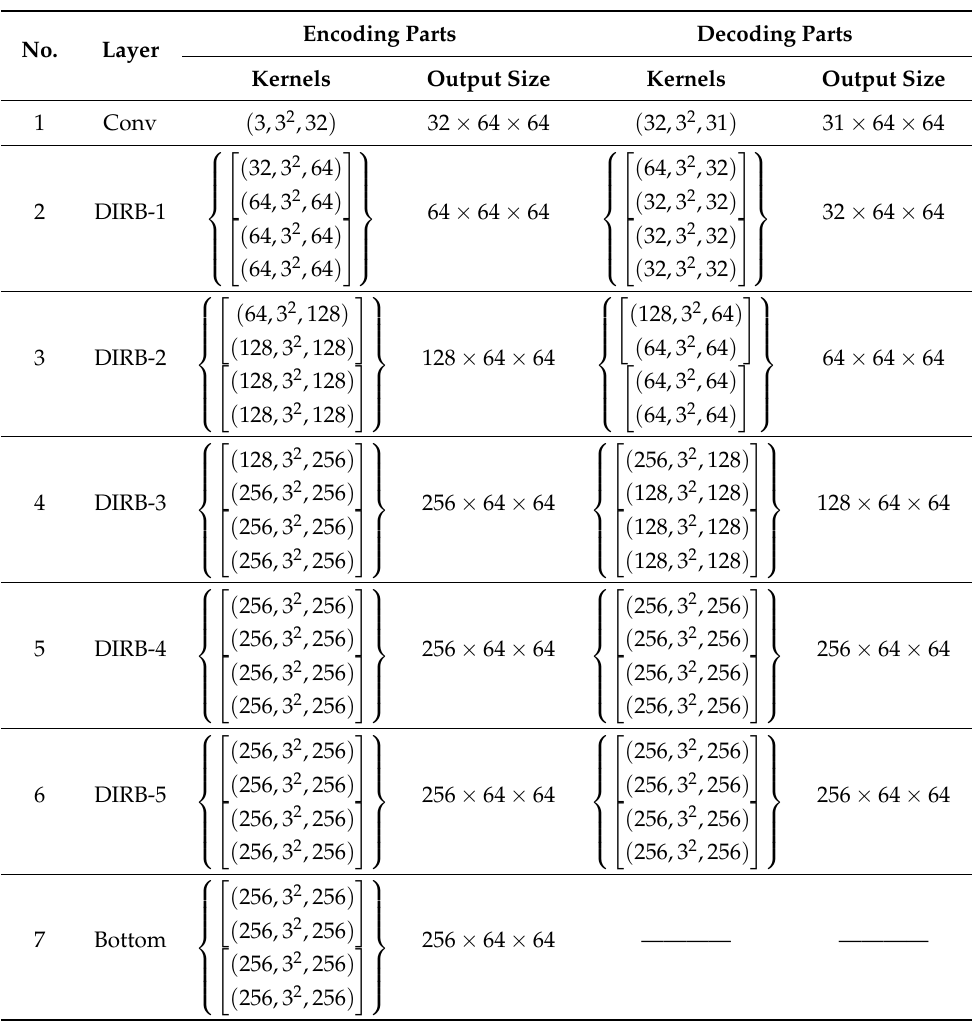
Table 1. Parameters settings for the backbone frameworks of our proposed RA 2 UN. ( · ) stands for the dimension of the convolutional kernels (input channels, kernel size 2 , filter number). The stride and padding of the convolution kernels are set to 1. The dimensions of the feature map are denoted by C × H × W ( H = W ) . C, H and W denote the channel, height and width of the feature map. {·} indicates the DIRB block. Four rows in kernels column denote the dimensions of the four convolutional kernels of each DIBR block. [ · ] is the improved residual